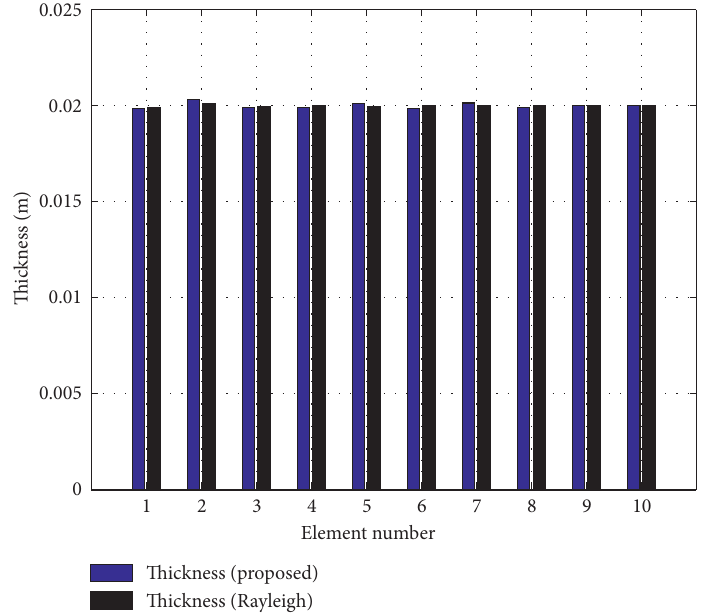
Figure 6: Updated thicknesses of each element for case 2.